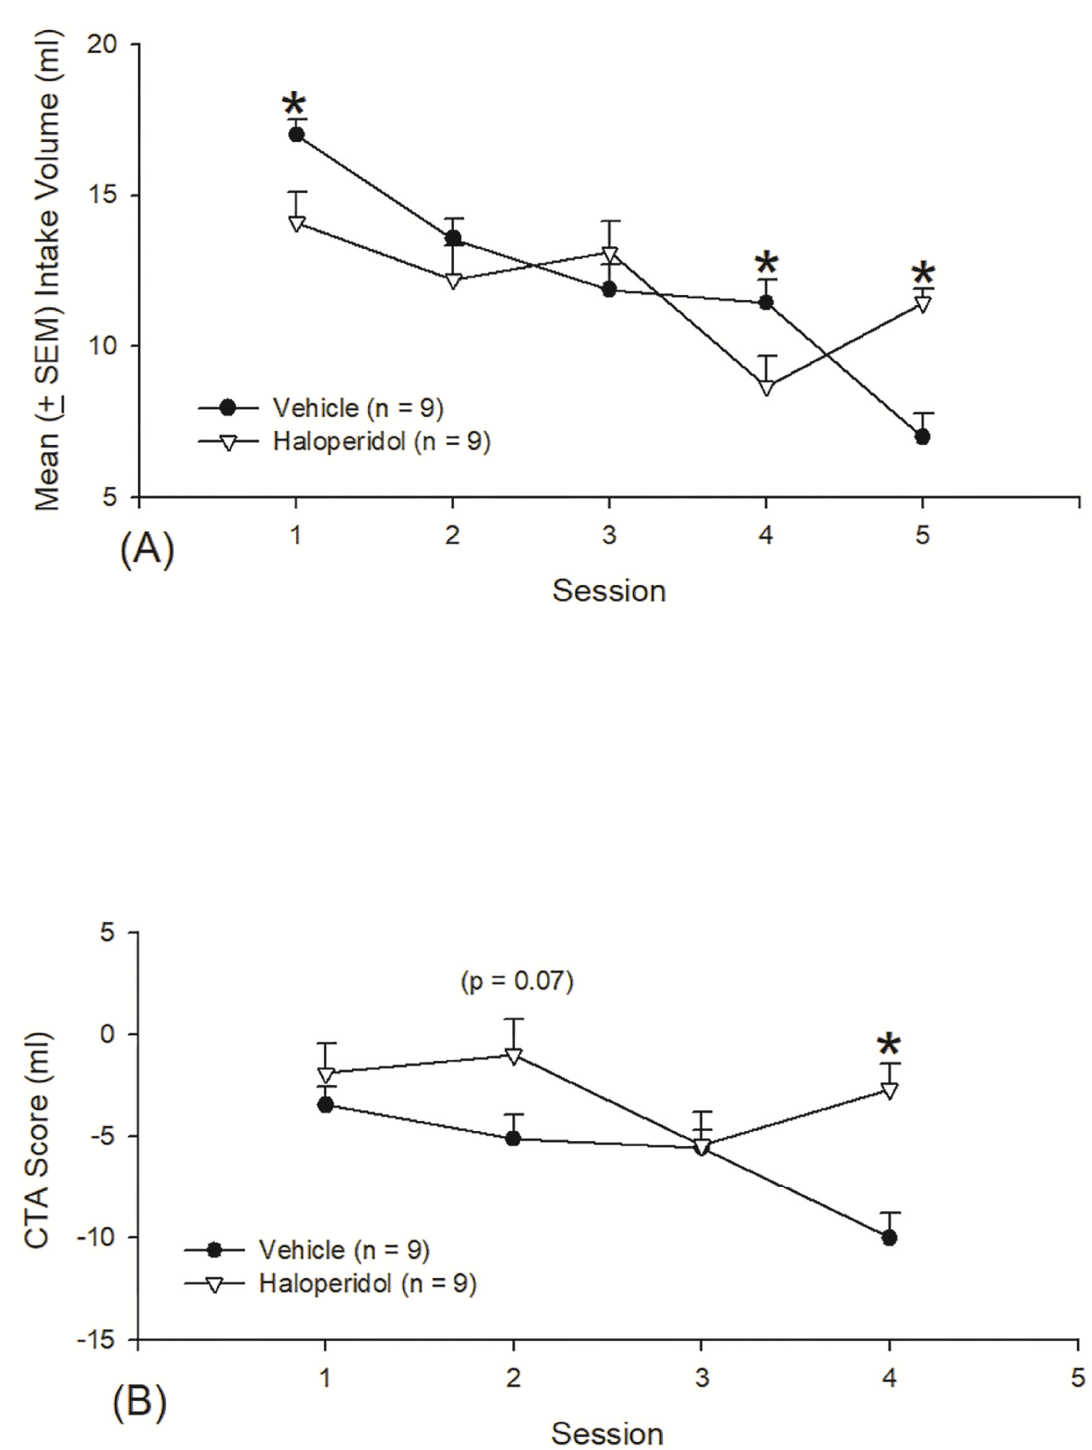
Figure 4. ( A ). Mean ( ± SEM) intake volume (mL) of 0.1% saccharin solution for the Vehicle (2% tartaric acid, n = 9) and Haloperidol ( n = 9) groups. All rats were allowed to freely drink a 0.1% saccharin solution for 15 min and then received microinjections of the basolateral amygdala with a 2% tartaric acid or haloperidol. Later, rats were given an intraperitoneal injection of a 0.15M LiCl solution. The procedure was one day for a session over 5 sessions. * p < 0.05 compared with the Vehicle group. ( B ). CTA scores (mL) for the Vehicle (2% tartaric acid, n = 9) and Haloperidol ( n = 9) groups over 4 sessions. * p < 0.05 compared with the Vehicle group.